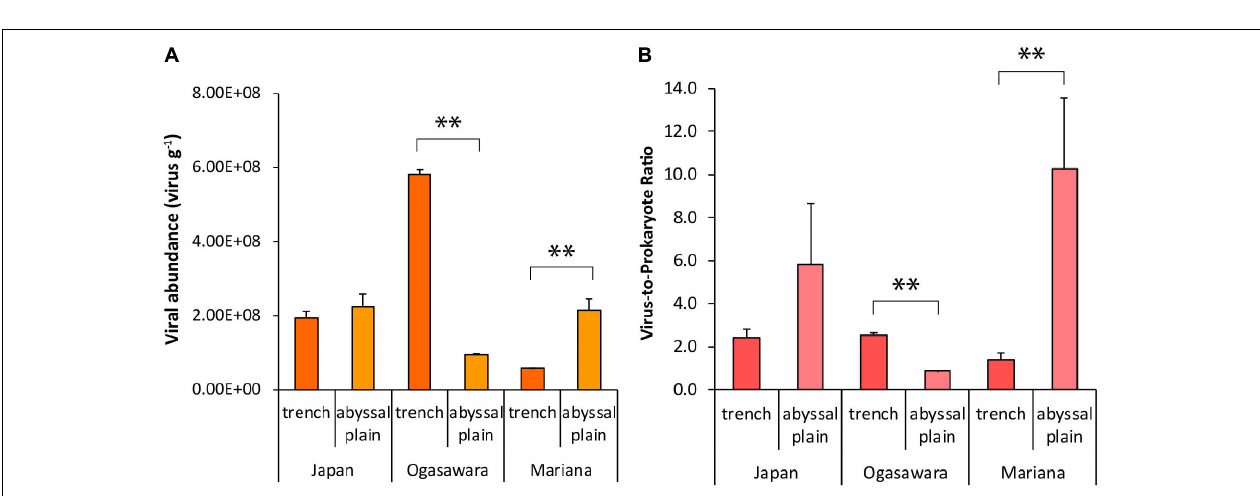
FIGURE 4 | (A) Viral abundance (particles g − 1 of dry weight sediment) and (B) virus-to-prokaryote ratio. Reported are the mean values and related SDs for each hadal trench site and related abyssal site. Statistical significance is tested between hadal trench sediments and abyssal sites. ∗∗ p < 0.01.